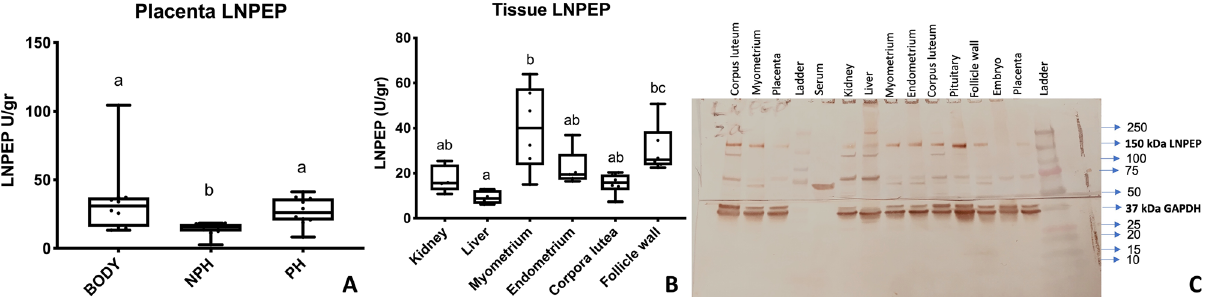
Figure 3. Median and interquartile (IQR) of oxytocinase (LNPEP) U/gr protein in: Panel A Body, Non- pregnant horn (NPH) and Pregnant horn (PH) of equine placenta (n = 7); Panel B LNPEP (U/gr) in different tissues from (n = 6) mares; and Panel C is a western blot performed using rabbit anti- LNPEP at 1:1000 (150 kDa) on the top portion of the gel and mouse anti-GAPDH (37 kDa) at 1:1000 on the bottom portion of the gel. Lane labels of corresponding tissues. Significance differences ( p ≤ 0.05) between tissues, and placental locations are indicated by different superscripted letters.